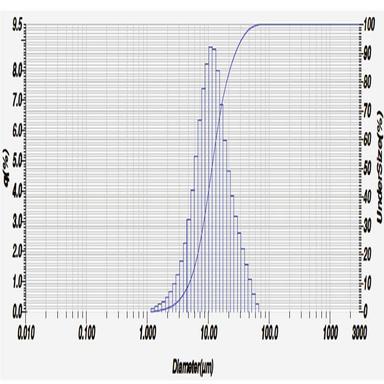
LPSD Analysis of S2.